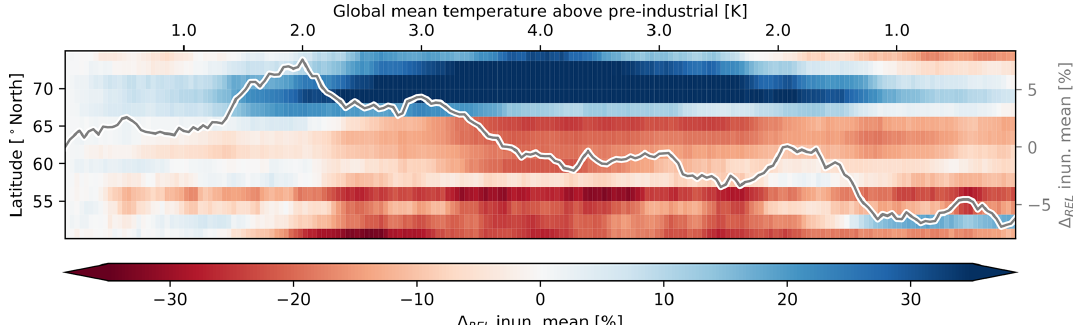
Figure 10. Wetland area in permafrost-affected regions. Relative change in the annual mean inundated area as a function of (global mean) temperature change and latitude (colour bar and left y axis) and averaged over the permafrost-affected regions (grey line, right y axis). Shown is the simulation with a temperature peak in